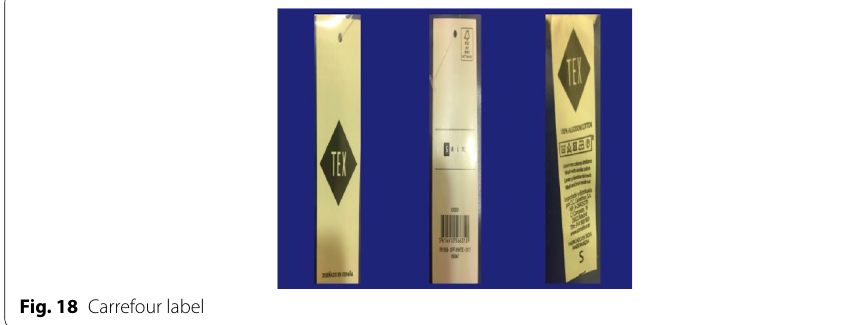
Fig. 18 Carrefour label